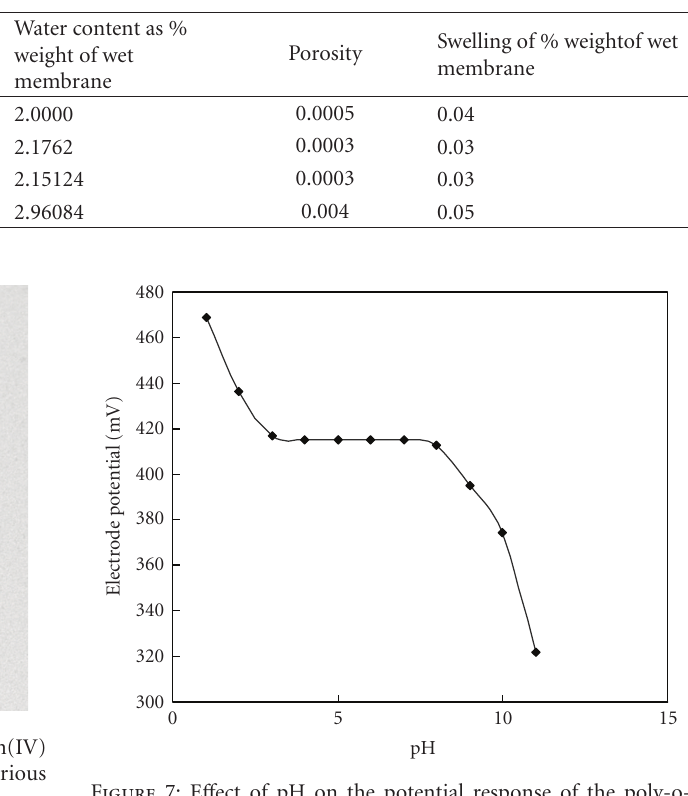
Figure 7: E ff ect of pH on the potential response of the poly-o- anisidine Sn(IV) arsenophosphate membrane electrode at 1 × 10 − 2 molL − 1 Pb 2+